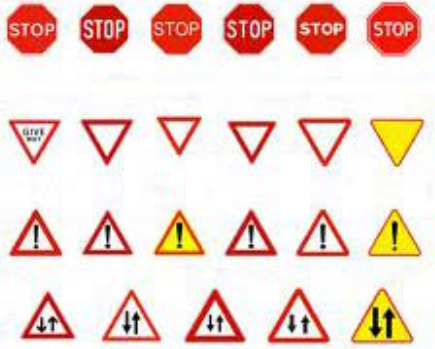
Figure 1. Differences between road signs from countries which have signed the Vienna